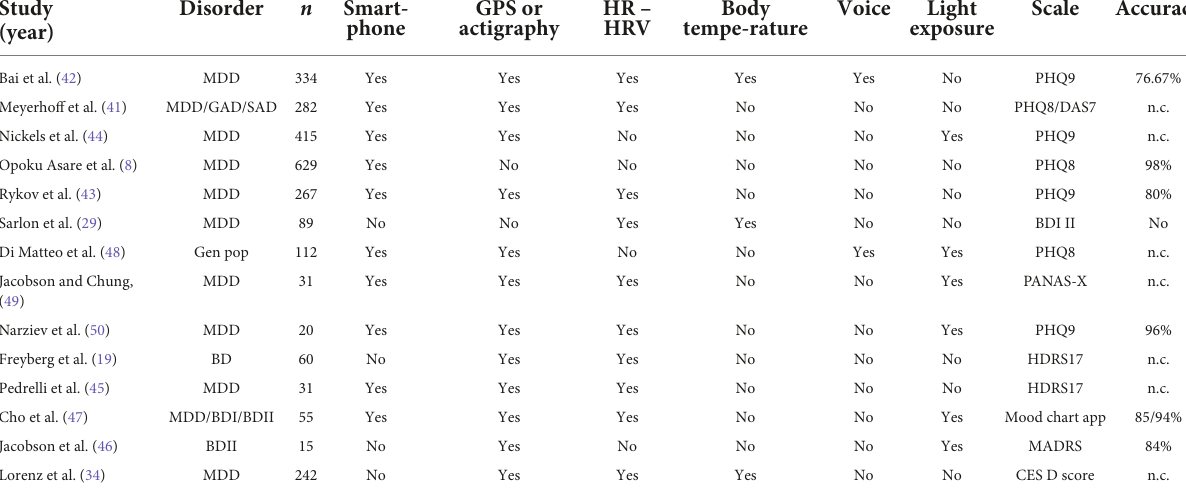
TABLE 2 Multimodal data